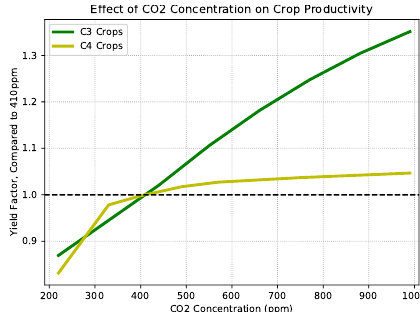
Figure 3. Yield factor for C3 (green) and C4 (yellow) crops versus CO 2 concentration. Crop productivity was acquired from [44], in which results from the DSSAT4 models [45] were interpolated based on CO 2 enrichment